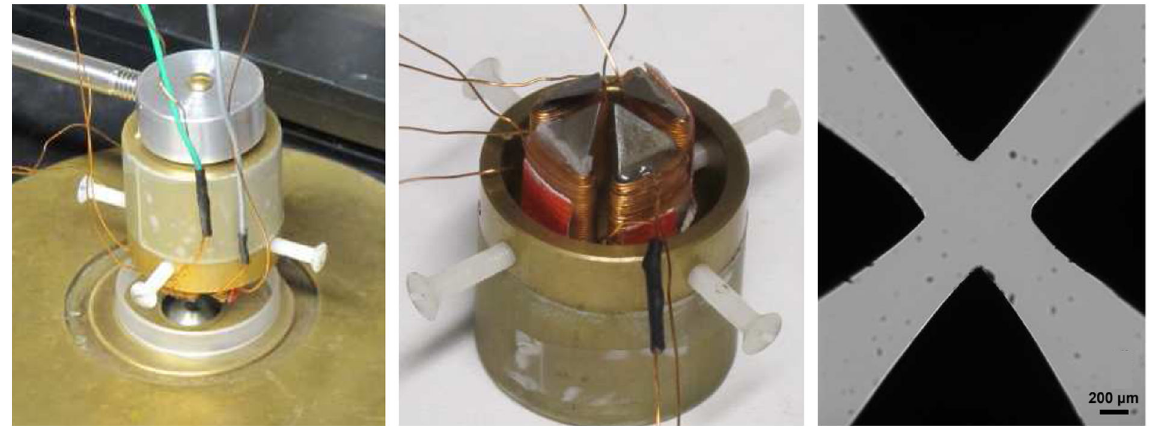
Figure 4. Magnetic device. (Left): The magnetic set-up was adapted to an inverted microscope with a plan 63x oil immersion lens. (Middle): It consists of two pairs of home-made coils magnetizing four engineered soft iron pieces. (Right): The space between the magnetic pieces is 0.6 mm, creating a strong magnetic field in the center (up to 70 mT for the maximum applied current of 1A). doi: